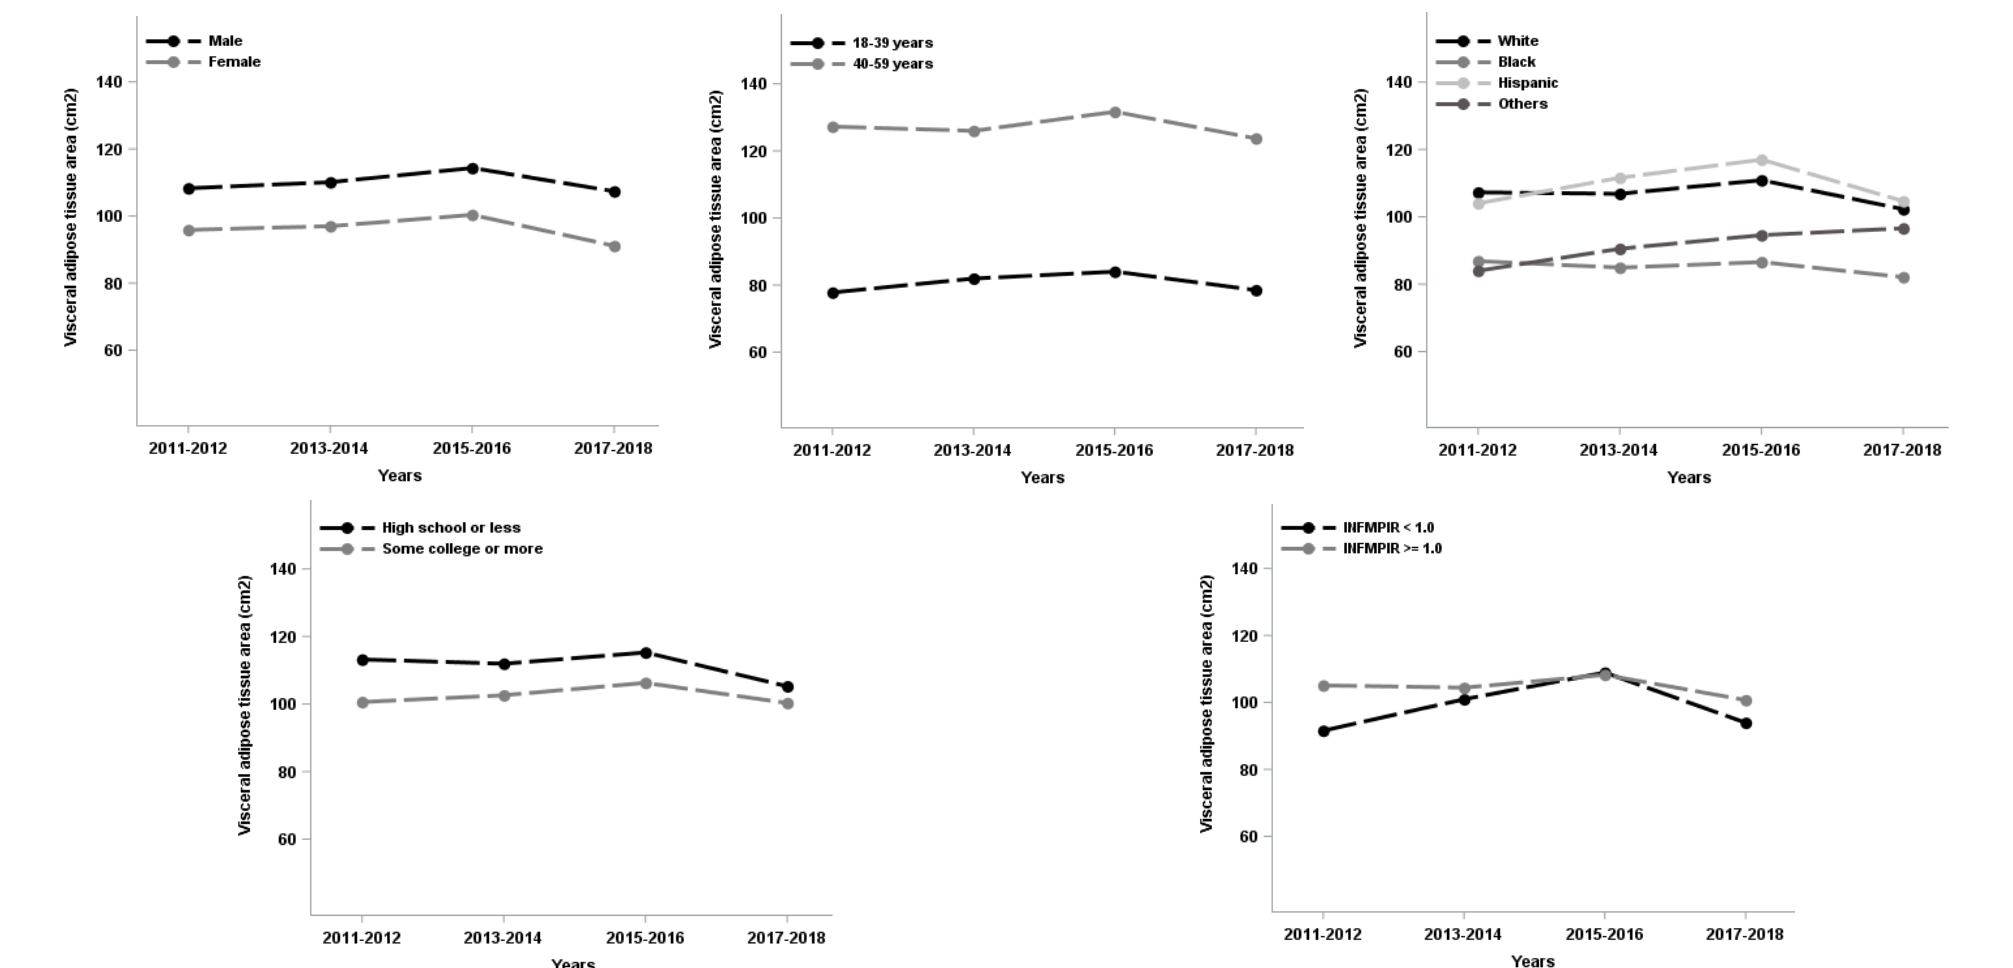
Figure 3. The visceral adipose tissue area trends in US adults by demographics, National Health and Nutrition Examination Survey 2011 – 2018. INFMPIR = the ratio of family income to the poverty level.